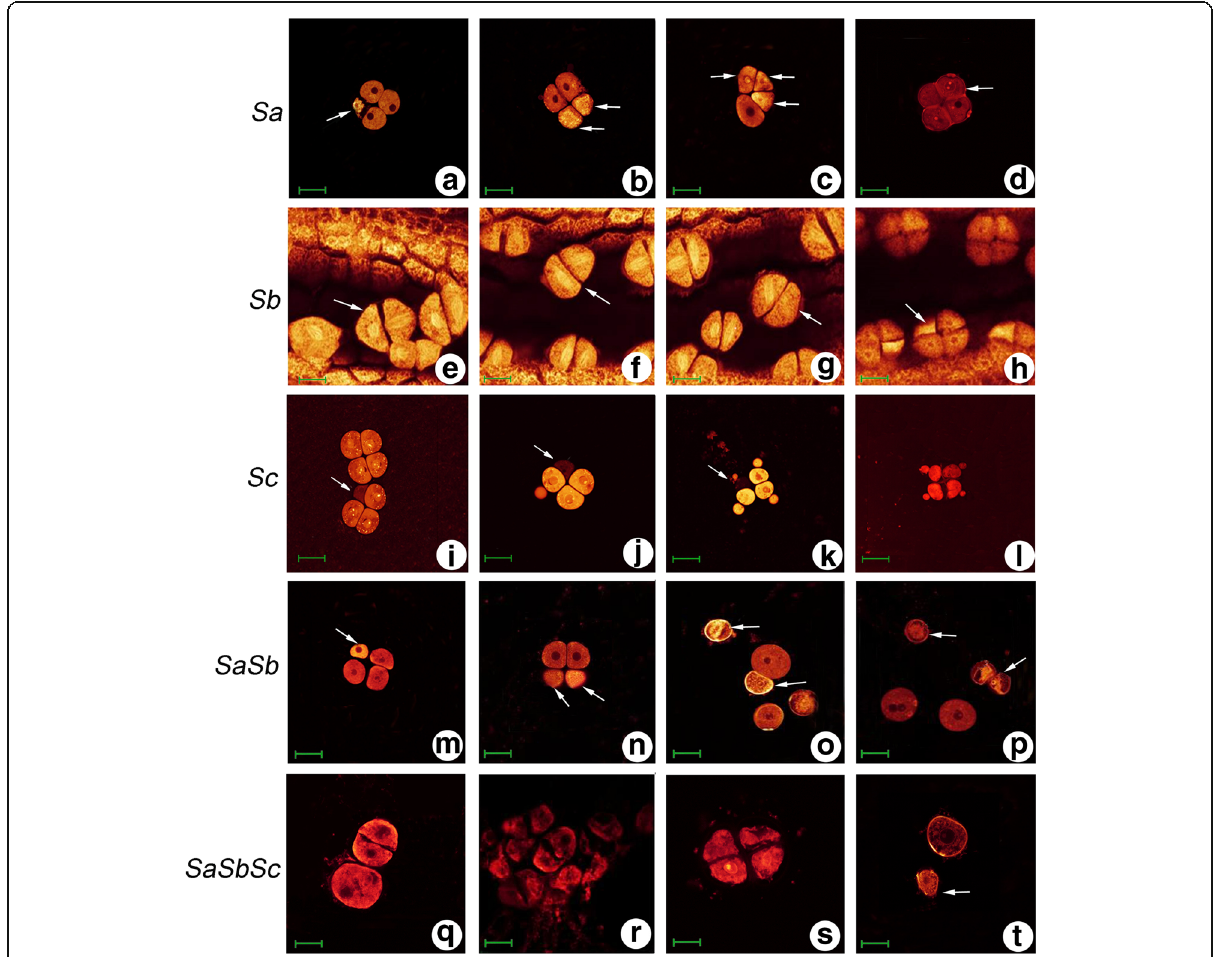
Fig. 2 Pollen abortion stages of autotetraploid rice hybrids with allelic interactions at Sa , Sb and Sc pollen sterility loci. a - d , Abnormal pollen development in a hybrid with interaction at Sa pollen sterility locus. a Tetrad stage, one microspore degradation. b Tetrad stage, two microspores degradation. c Tetrad stage, morphological abnormalities. d Tetrad stage, callose remained after completion of meiosis. e - h , Abnormal pollen development in a hybrid with interaction at Sb pollen sterility locus. e Metaphase II, spindle abnormalities. f Metaphase II, spindle abnormalities. g Metaphase II, spindle abnormalities. h Tetrad stage, one microspore degradation. i-l , Abnormal pollen development in a hybrid with the interaction of Sc pollen sterility locus. i Tetrad stage, microspore degradation. j Tetrad stage, microspore degradation. k Tetrad stage, microspore degradation. l Tetrad stage, cell shrinkage. m - p , Abnormal pollen development in a hybrid with interactions at SaSb pollen sterility loci. m Tetrad stage, one microspore degradation. n Tetrad stage, two microspores degradation. o Middle microspore stage, cell shrinkage. p Middle microspore stage, cell shrinkage. q - t , Abnormal pollen development in a hybrid with the interactions of SaSbSc pollen sterility loci. q Dyad stage, cell shrinkage. r Dyad stage, cell shrinkage. s Tetrad stage, cell shrinkage. t Middle microspore stage, cell shrinkage. Bars =40 μ